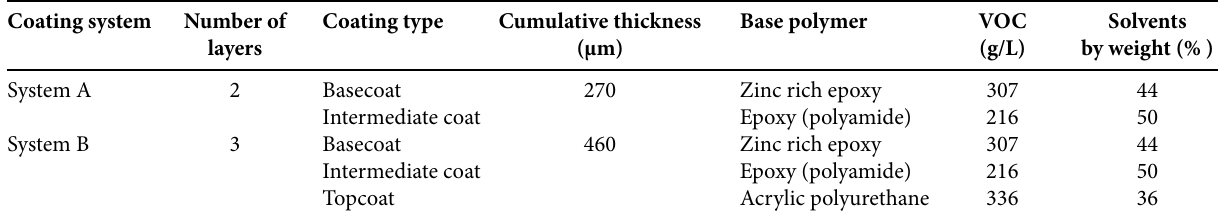
Table 1. Specifications for the investigated commercial coating systems Coating